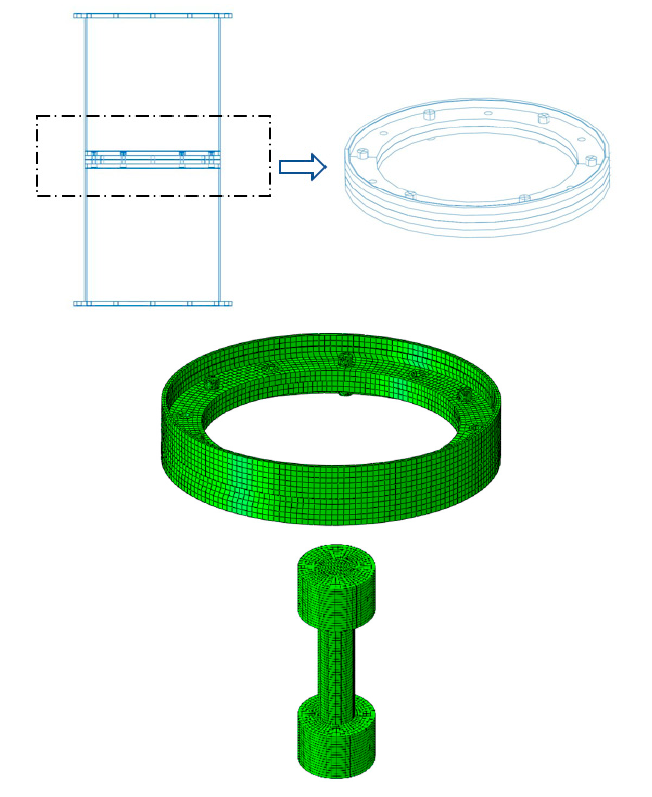
Figure 5. Bolted flange of the rocket connection structure.